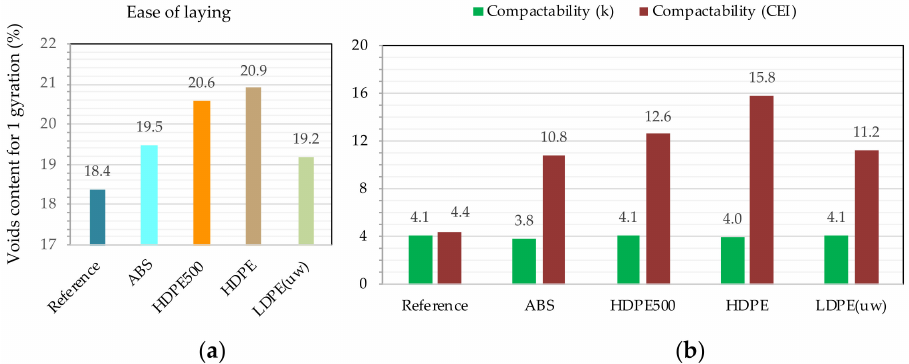
Figure 8. Workability of reference and asphalt concrete with 6% of different plastic waste used as additives: ( a ) ease of laying and ( b ) compactability based on k and CEI